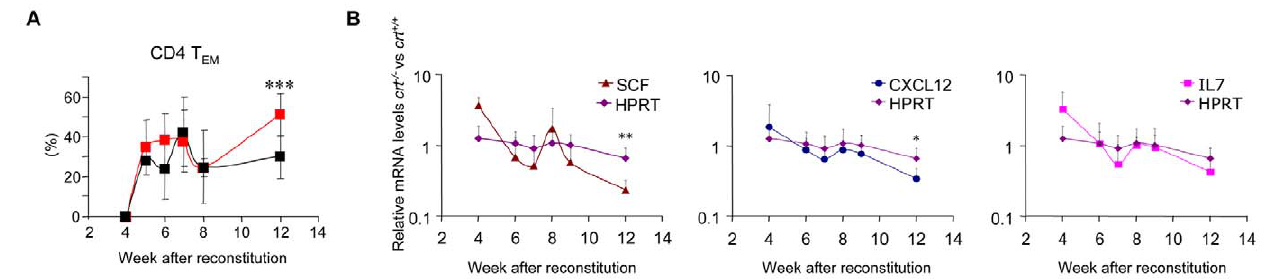
Figure 4. Kinetics of peripheral effector/memory T cells and transcripts in BM from FLC. (A) Percentages of peripheral CD4 effector/ memory T cells in lymph nodes measured at different times following reconstitution of RAG/ c chain DKO mice with crt + / + and crt 2 / 2 fetal liver progenitors (mean 6 SD of at least 5 mice). Black line, crt + / + ; red line, crt 2 / 2 ; ***= P , 0.001. (B) Quantification by real time PCR of SCF, CXCL12, IL-7 and HPRT transcripts in BM at different time points after reconstitution (mean 6 SD of at least 3 samples), **= P , 0.01 and *= P , 0.05.